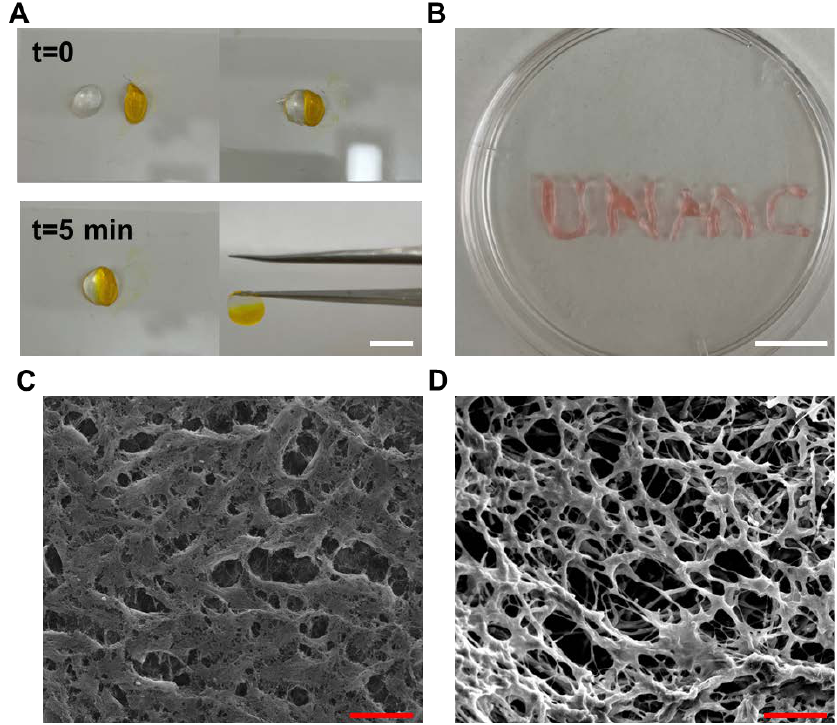
Figure 3. Macro- and micro-scopical characterization of Alg -PBA hydrogels. ( A ) Illustration of self - healing property of dynamic hydrogel; ( B ) Syringe injectability of Alg-PBA- PVA hydrogel; ( C , D ) SEM images of dynamic hydrogel before ( C ) and after ( D ) CaCl 2 crosslinking. Scale bar (white) 5 mm, scale bar (red) 25 µm. scale bar (red) 25 µ